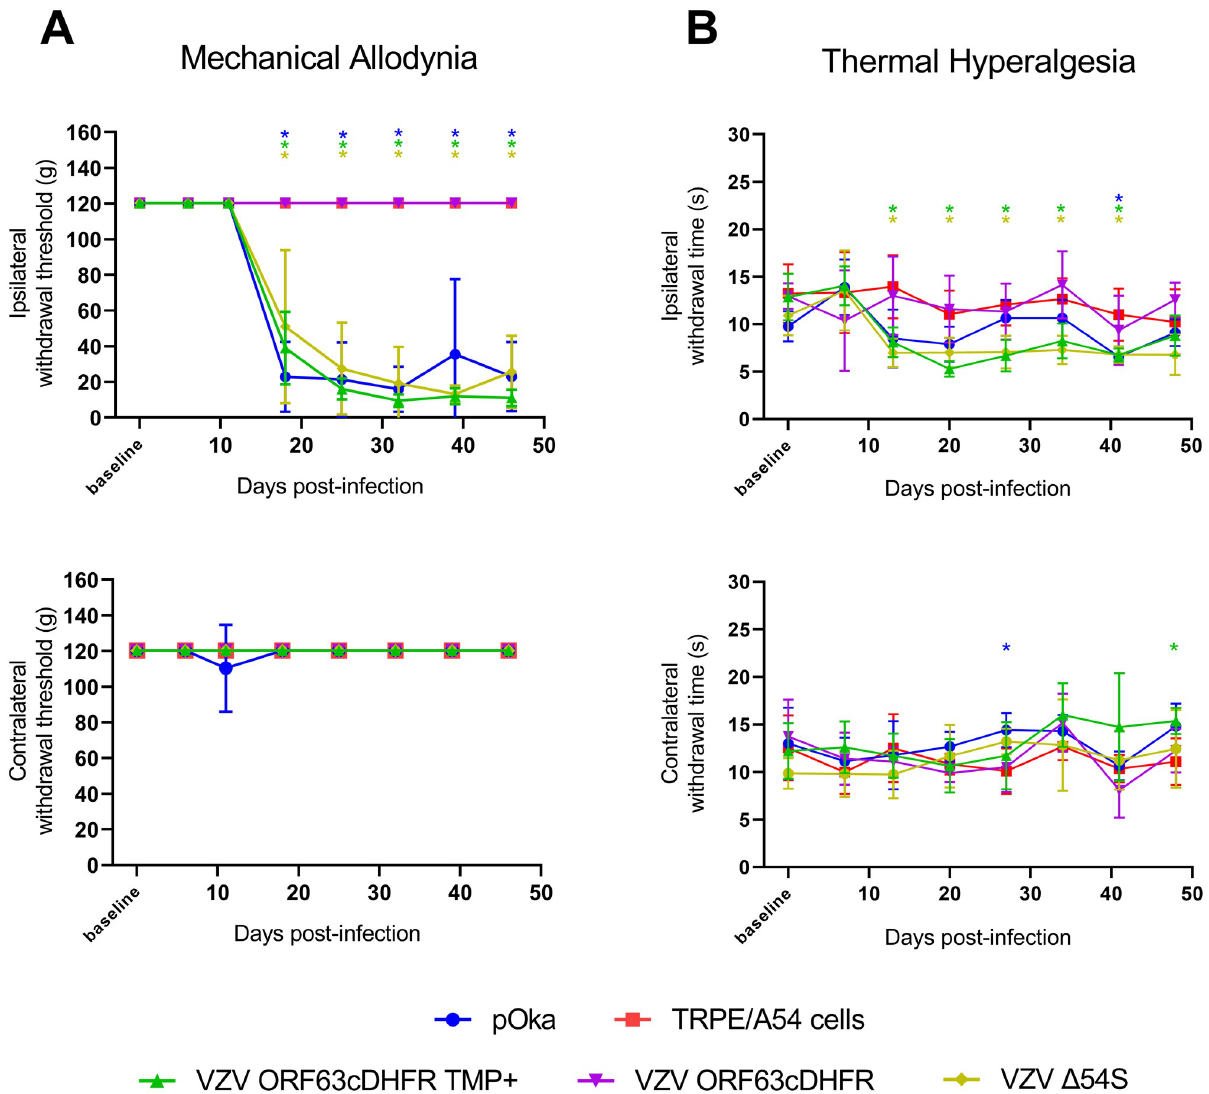
Fig 11. Induction of mechanical and thermal hypersensitivity by VZV with conditionally stabilized IE63 or by VZV lacking the production of the ORF54 portal protein. Male Sprague-Dawley rats (n = 6/group) were inoculated with 2x10 5 PFU pOka (blue circle), VZV ORF63cDHFR with 500 nM TMP (green triangle) or without TMP (purple triangle), VZV Δ 54S (yellow diamond), or uninfected cell equivalents (red square) and subjected to the same testing methods in Fig 6. (A) Mechanical hypersensitivity of inoculated footpad (top) vs contralateral (bottom). (B) The same group of rats were tested for thermal hypersensitivity of inoculated footpad (top) vs contralateral (bottom). Error bars: SD. Statistics: Two-way ANOVA with Bonferroni multiple comparison to TRPE negative control where � p < .05. Note: The uninfected cell equivalents (red square) in this figure represent inoculated rats n = 3 A54 cells and n = 3 TRPE cells. This data has been combined for clarity and was deemed appropriate as the cell lines are from a common lineage.